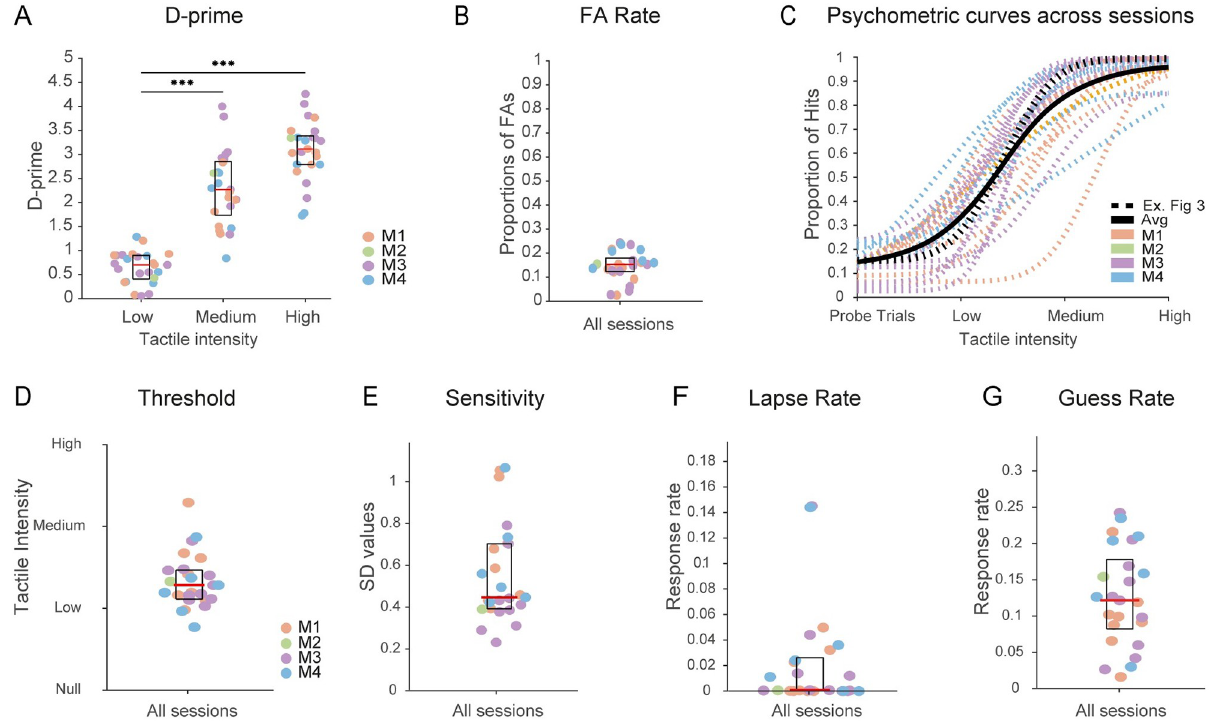
Fig 4. Behavioural performance. (A) D-prime values for each of the tactile intensities (Low, Medium, High). Orange, Green, Violet, and Blue dots correspond to each mouse (M1-4). *** Significant difference between low and medium tactile intensity (one-way ANOVA, F (2,72) = [105.1], P = 4.44 x 10 − 22 , Bonferroni post hoc test, P = 4.7 x 10 − 14 ) as well as between low and high intensity (one-way ANOVA, F (2,72) = [105.1], P = 4.44 x 10 − 22 , Bonferroni post hoc test, P = 4.23 x 10 − 22 ). (B) FA rates across all sessions in the Final Stage. (C) Psychometric curves of all mice. Coloured dashed lines are individual sessions belonging to each mouse (M1-4). The solid black line is the average from all sessions. The dashed black line corresponds to the example session shown in Fig 3A and 3B. (D-G) Threshold, sensitivity, lapse rate and guess rate computed from the psychometric curves. NS.: Statistical significance was not found between mice for any of these five features (one-way